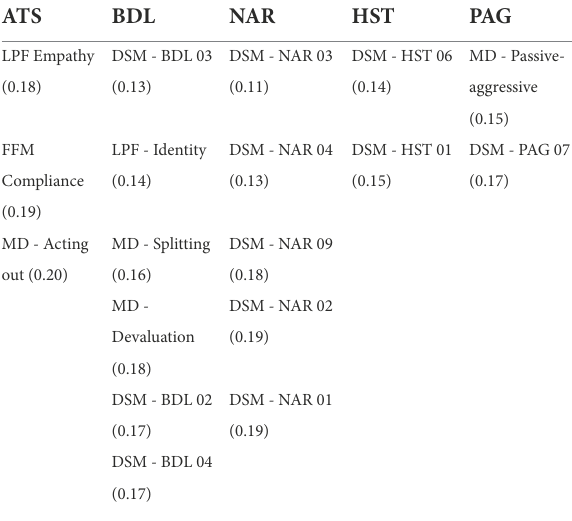
TABLE 8 Symptoms having a positive likelihood ratio (given in parenthesis) lower or equal than 0.2 for some personality disorder.